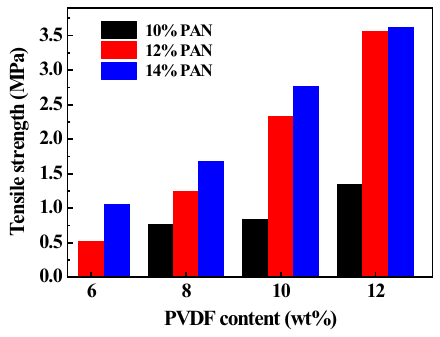
Fig. 4 The tensile strength of nanofibrous membrane fabricated from different PAN and PVDF